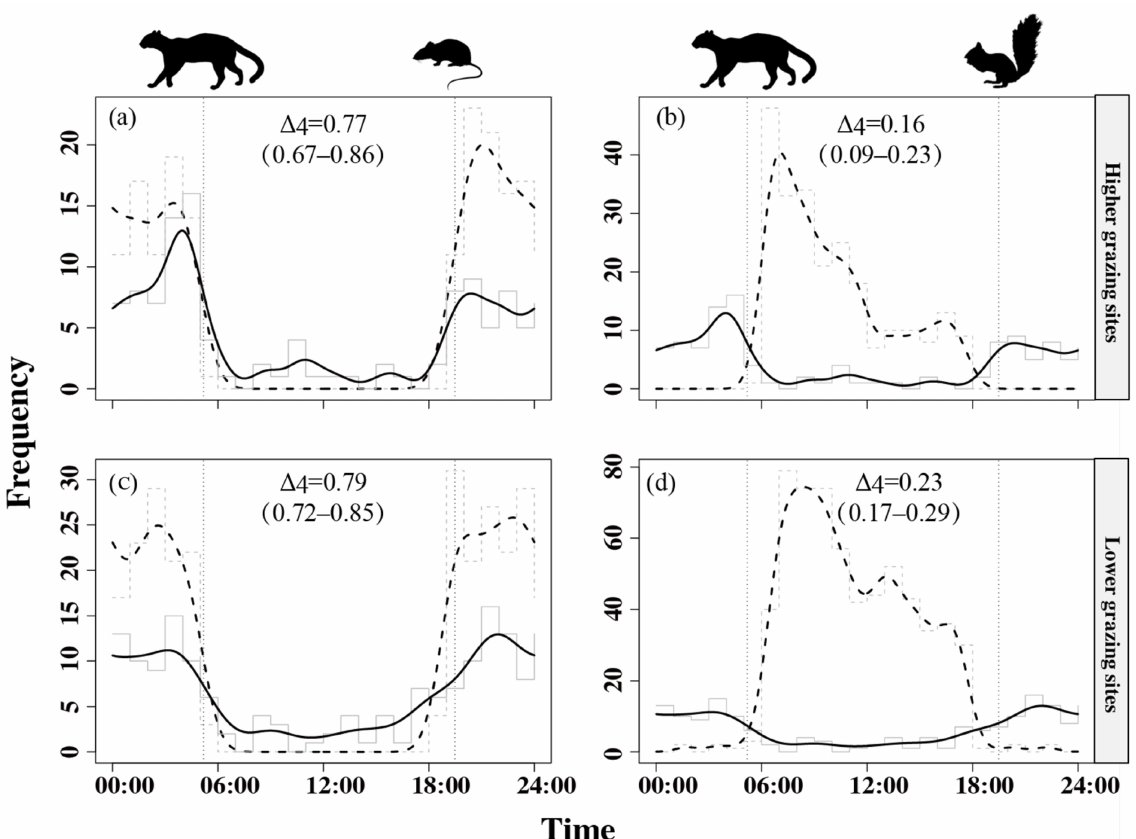
Figure 6. Pairwise comparisons of daily activity patterns between leopard cats (solid curves) and their prey (dashed curves) in higher ( a , b ) and lower grazing sites ( c , d ). The overlap coefficients ( ∆ ) and their respective 95% confident intervals are shown at the top of each graph. The vertical black dashed lines on the x -axis represent sunrise and